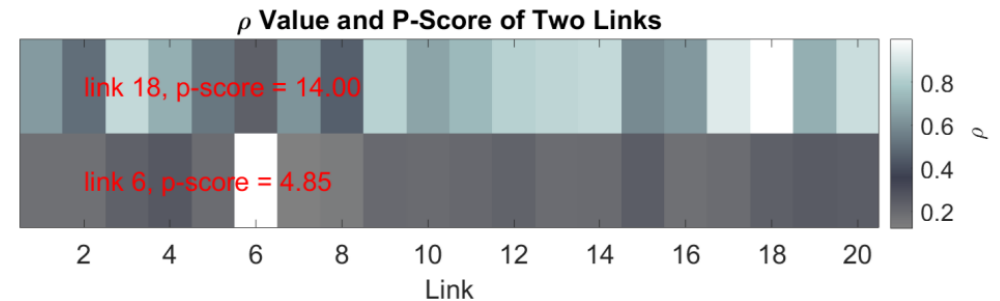
Figure 2. 𝜌 Value of Two Links with the Highest and Lowest p-score. Figure 2. ρ Value of Two Links with the Highest and Lowest